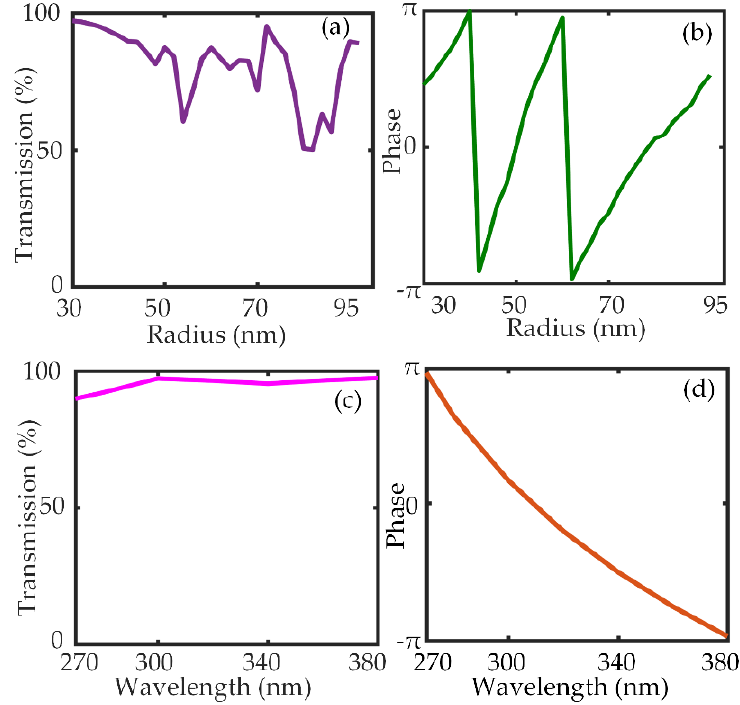
Figure 2. ( a ) Transmission as a function of radius. ( b ) Phase as a function of radius. ( c ) Transmission as a function of wavelength at R = 36 nm. ( d ) Phase as a function of wavelength at R = 36 nm.